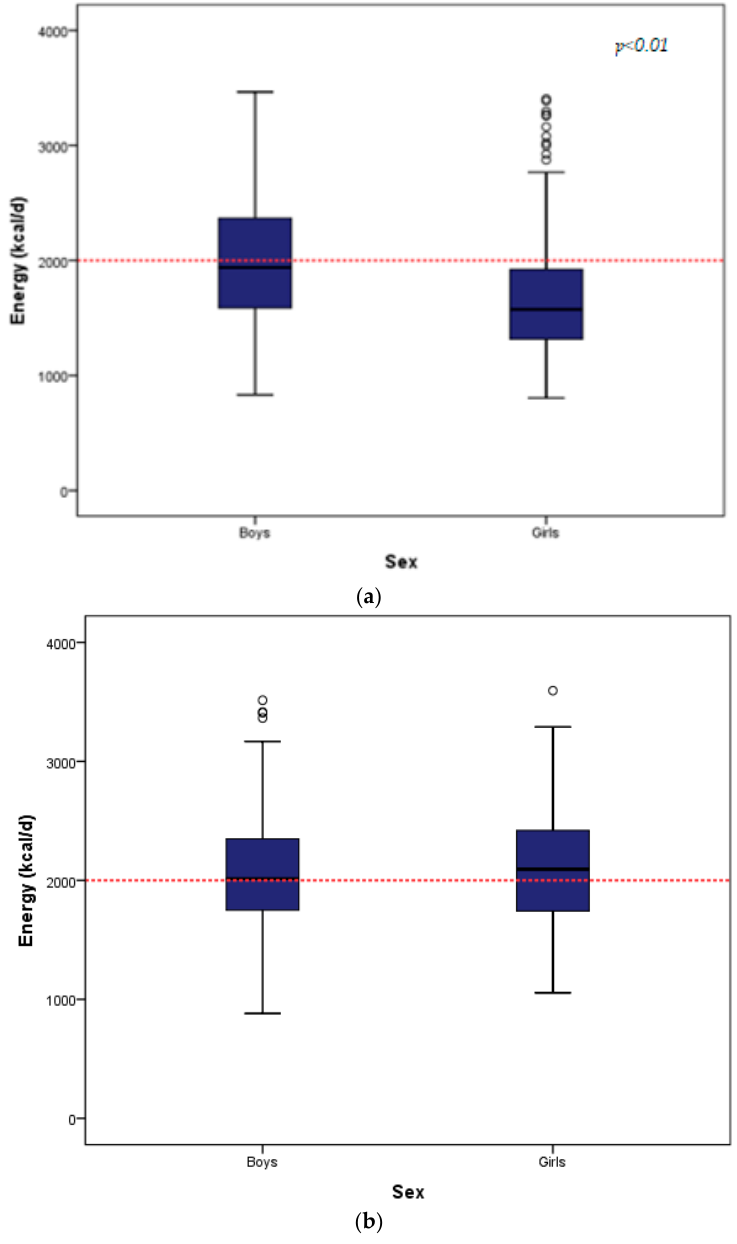
Figure 1. ( a ) Boxplot of daily caloric intake in the TEENAGE study. ( b ) Boxplot of daily caloric intake in the STANISLAS Family Study.